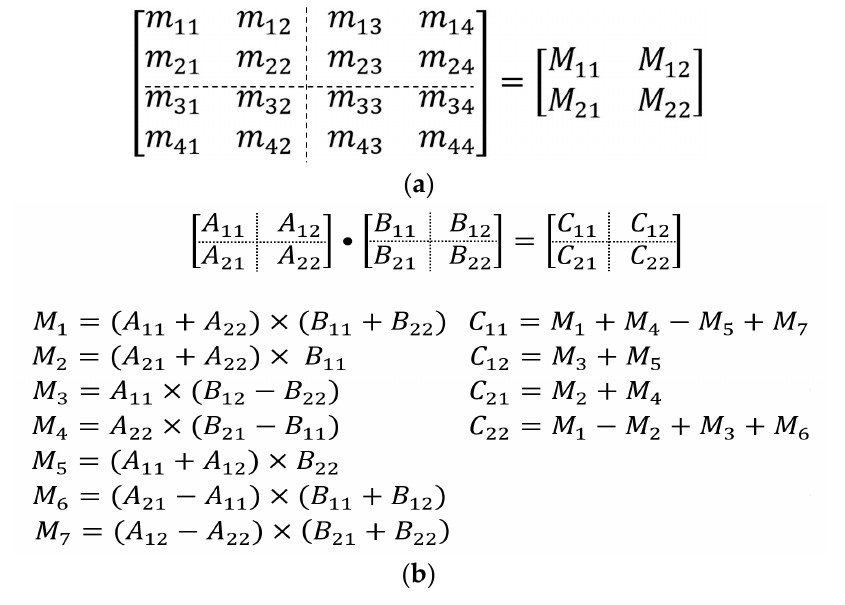
Figure 5. Proposed 4 × 4 matrix multiplication method: ( a ) Partitioning of a 4 × 4 matrix into a 2 × 2 sub-matrices; ( b ) proposed matrix multiplication: Naïve (×) and Strassen (•).